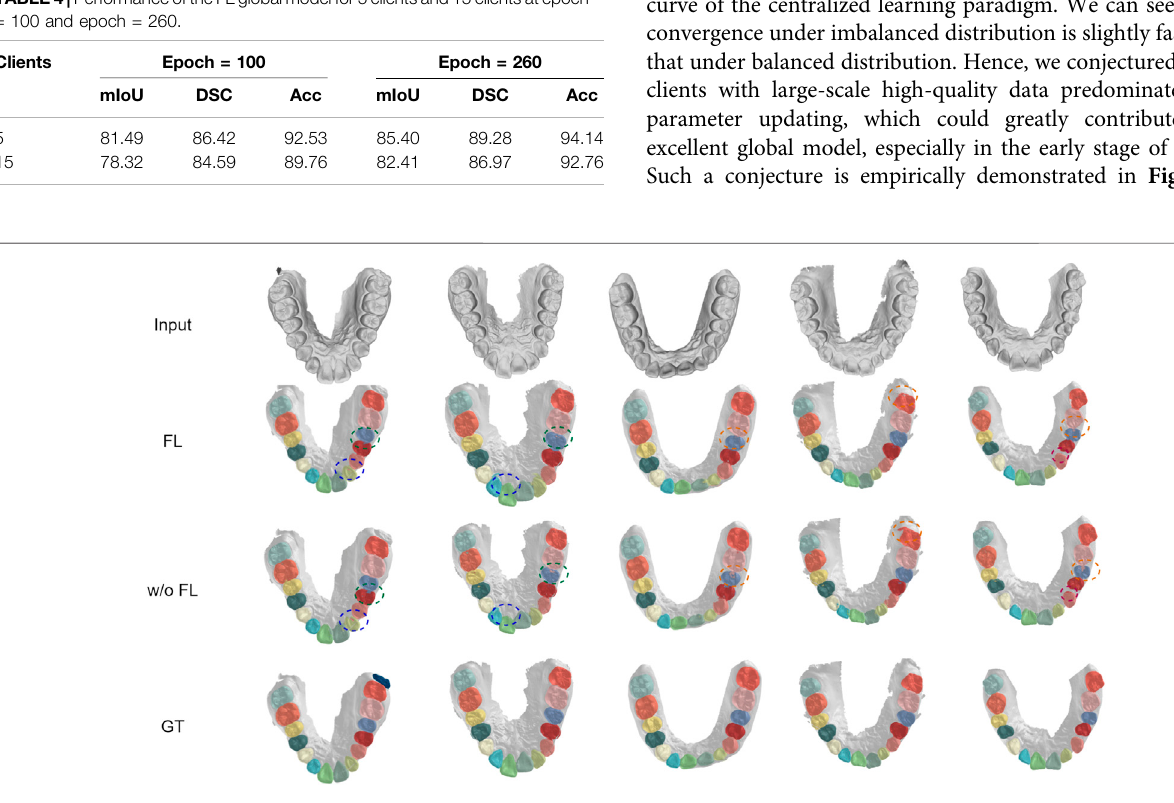
FIGURE 5 | Visualization of segmentation results under balanced distribution with FedTSeg framework and without FedTSeg framework. “ FL ” denotes the global model with FedTSeg and “ w/o FL ” denotes the local model under pure local training. The differences are annotated with dotted circles.